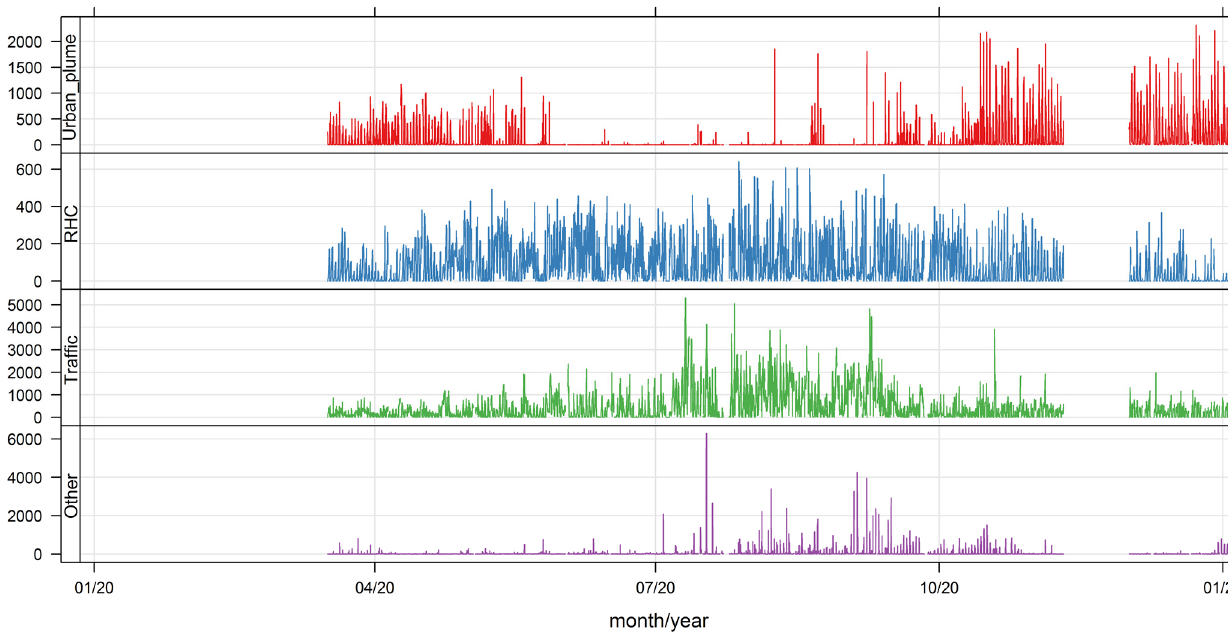
Figure A7. Bivariate plot of hourly BC wb contributions, 2020 campaign, using pressure instead of wind speed.